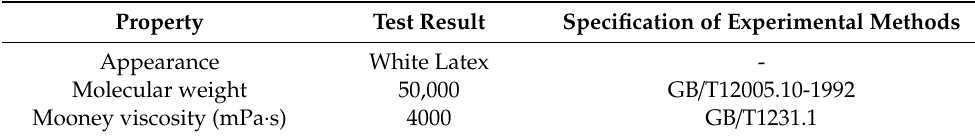
Table 3. Technical performance of styrene-butadiene rubber (SBR) latex.